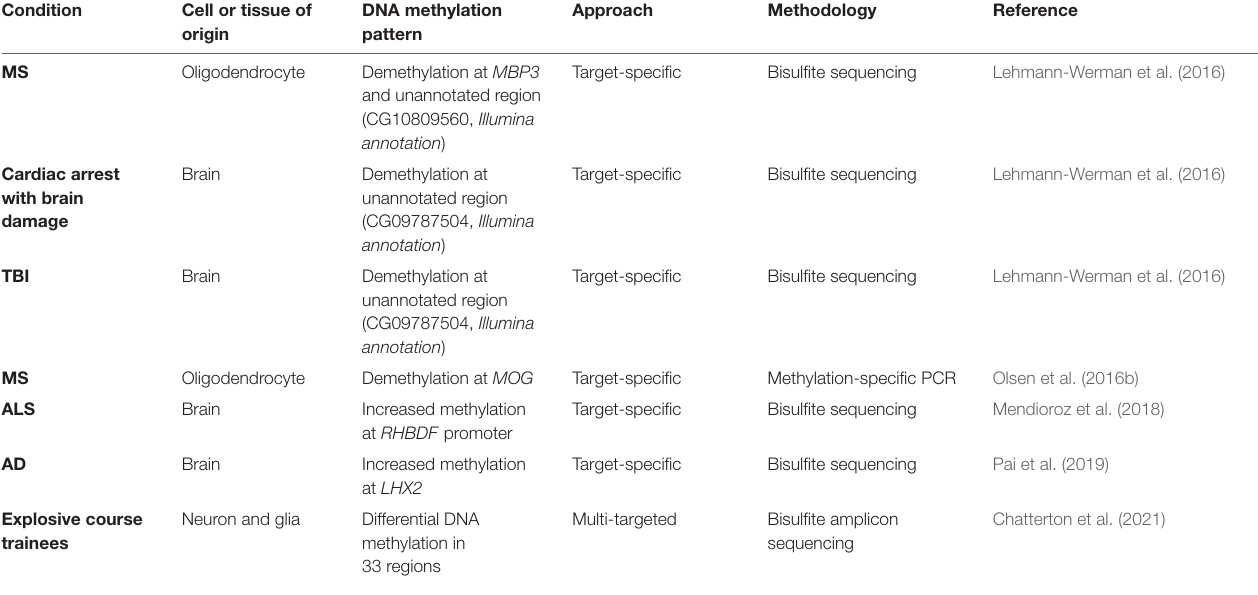
TABLE 1 | Evidence of CNS-derived cfDNA in neurodegenerative